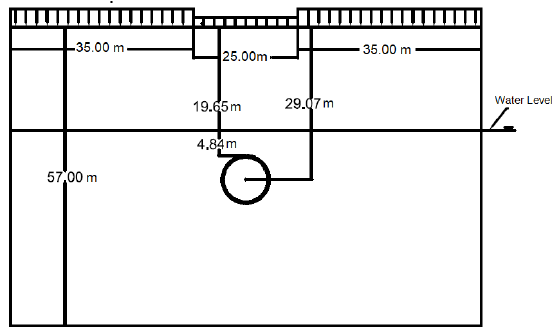
Figure 14: Groundwater conditions in the model